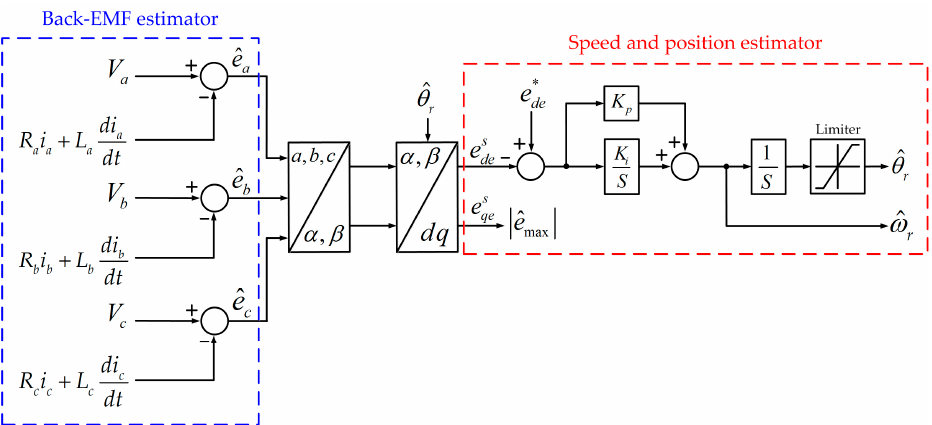
Figure 3. Block diagram of back-EMF, speed and position estimator.